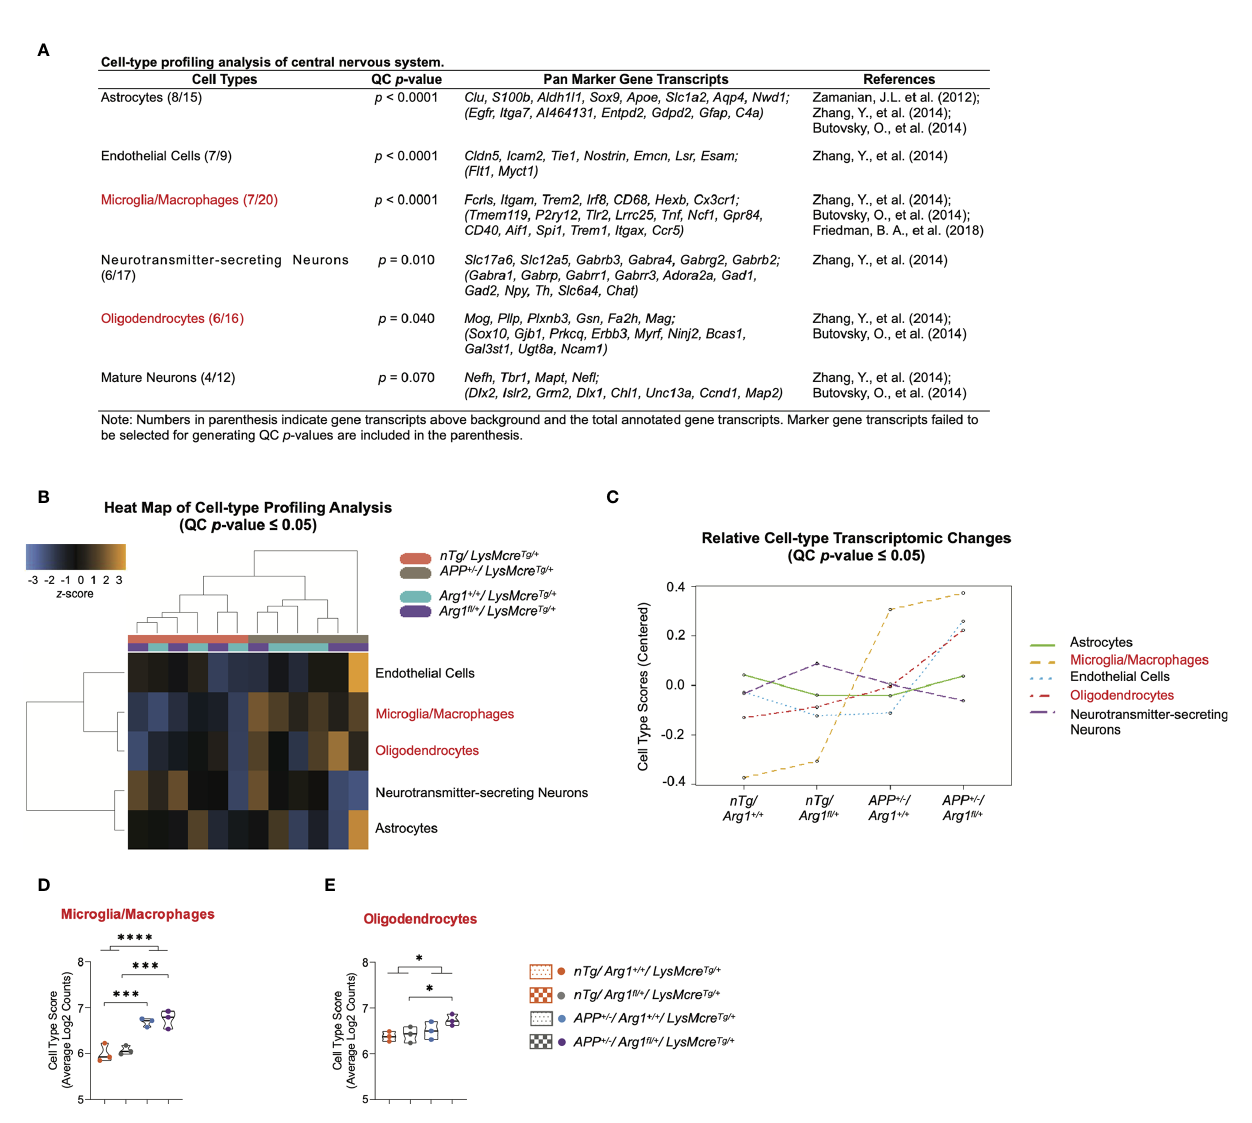
FIGURE 4 | Cell-type pro fi ling analysis of the central nervous system. (A) A table lists central nervous system cell types, QC p -value, pan marker gene transcripts, and references. (B) Heat map of cell-type pro fi ling analysis provides an overview of cell-type distribution and clustering across all samples within two covariates of genotype. The z -score color in orange or blue indicates a high or low abundance of cell-type-speci fi c gene transcripts, respectively. All scores are presented on the same scale via a z -transformation. (C) A line plot of relative cell-type transcriptomic changes in selected marker gene transcripts ’ abundance across groups. Each cell type score was centered to zero value. (D, E) Cell type scores of microglia/macrophages (D) and oligodendrocytes (E) are displayed in a violin plot against four groups. All samples are displayed, and the median is denoted with a line. n=3 samples per group representing 6 mice. Cell types highlighted in red indicates main APP transgene genotype effect in cell type scores. The asterisk sign (*) indicates the main effect of APP transgene genotype and its pair-wise comparisons. * p < 0.05; *** p < 0.001; **** p < 0.0001. Two-way ANOVA of 2x2 factorial analysis followed by pairwise comparisons using Fisher ’ s